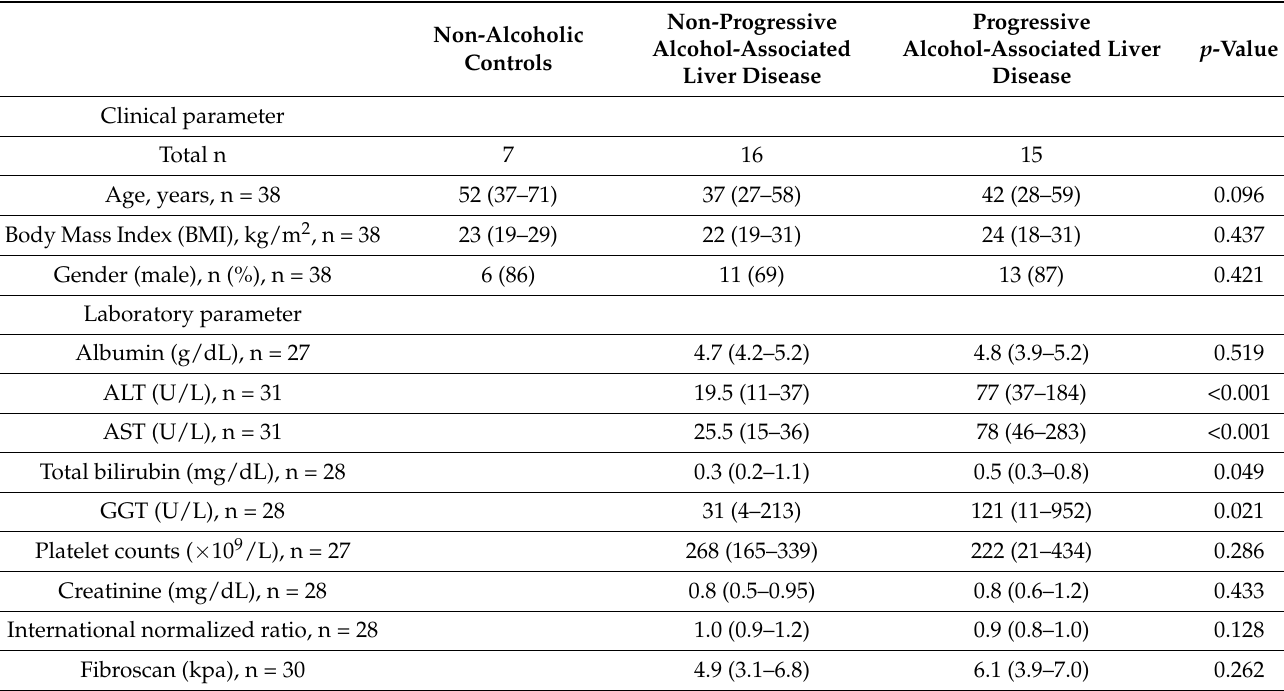
Table 1. Subject